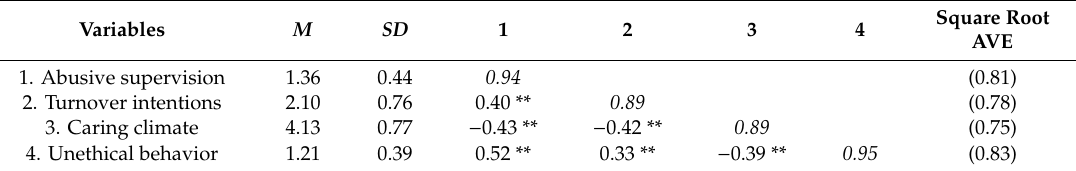
Table 2. Descriptive statistics, correlations, and